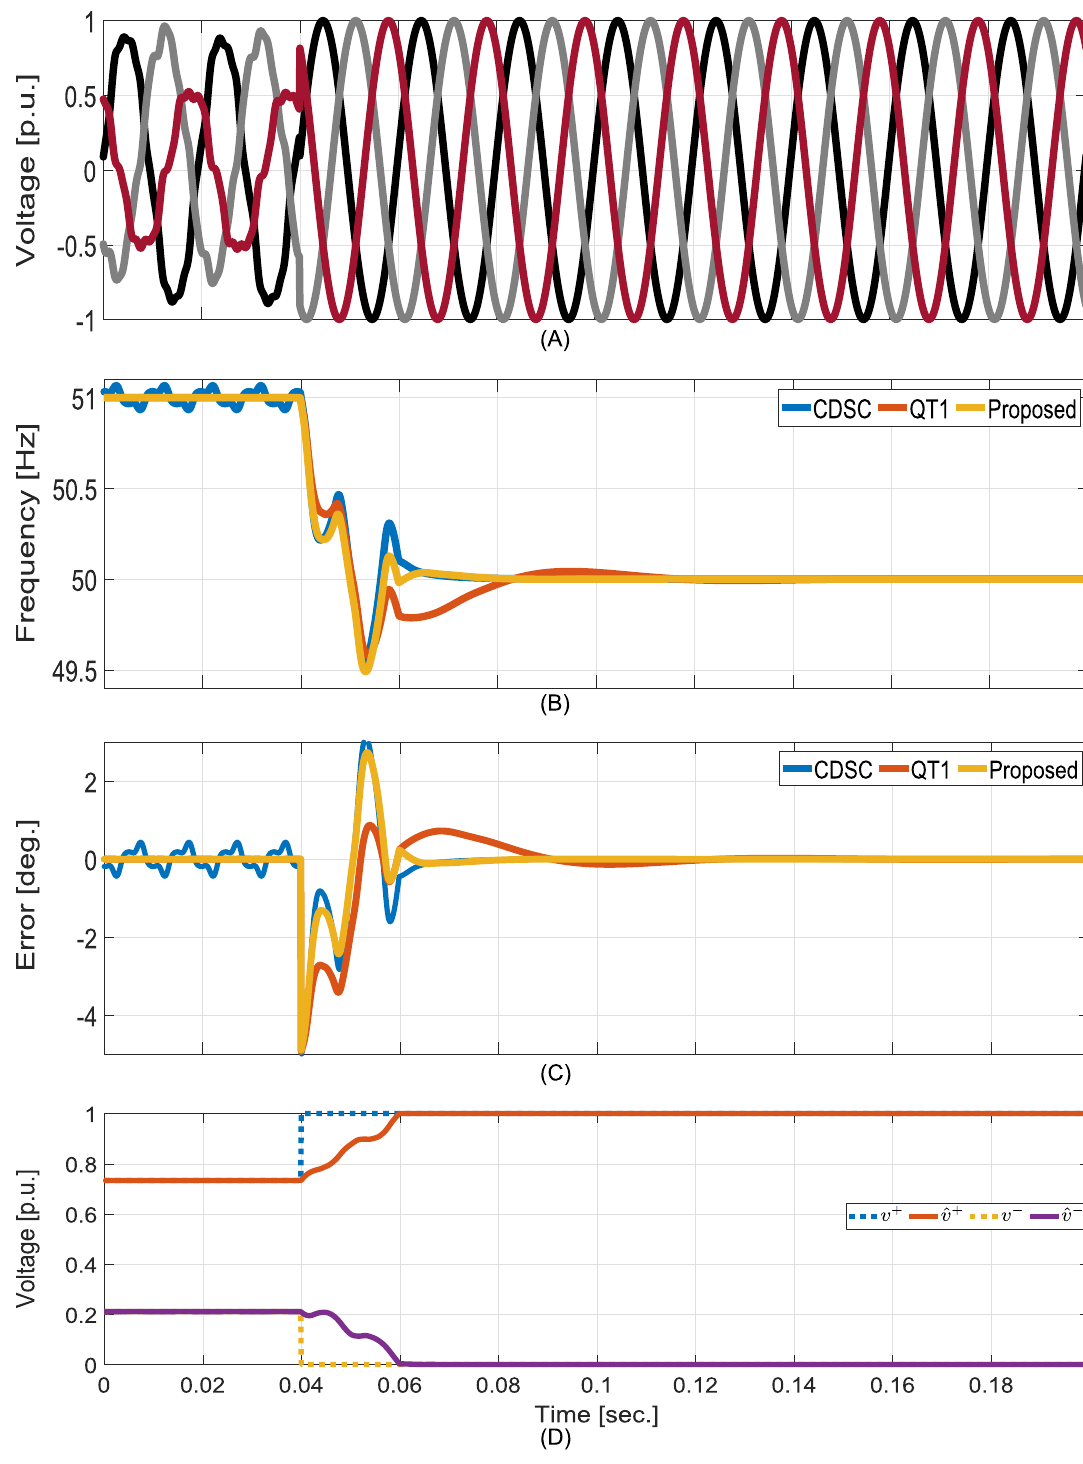
Fig 6. Comparative numerical simulation results for unbalanced and distorted to balanced test. A: Grid voltages. B: Estimated frequency. C: FFPS phase estimation error. D: Estimated FFPS and FFNS amplitudes.